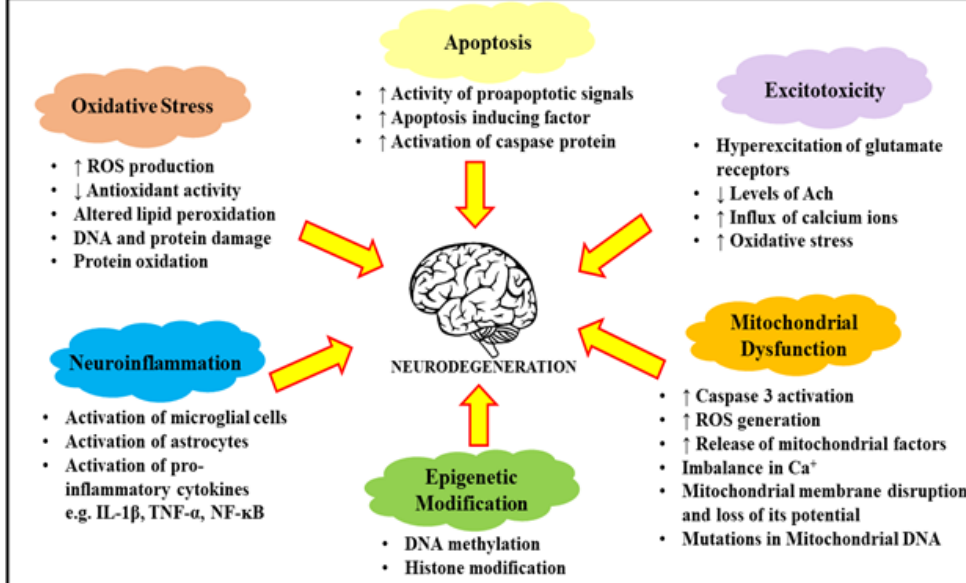
Figure 1. Description of factors leading to neurodegeneration processes. The further progression of these processes leads to the exacerbation of apoptotic factors, the increase in oxidative stress and excitotoxicity, neuroinflammation and mitochondrial dysfunction. ROS: reactive oxygen species; DNA: deoxy ribonucleic acid; Ach: Acetylcholine; IL-1 β : interleukin 1 β ; TNF- α : Tumor necrosis factor- α; NF - ҡB: Nuclear factor kapp a B.